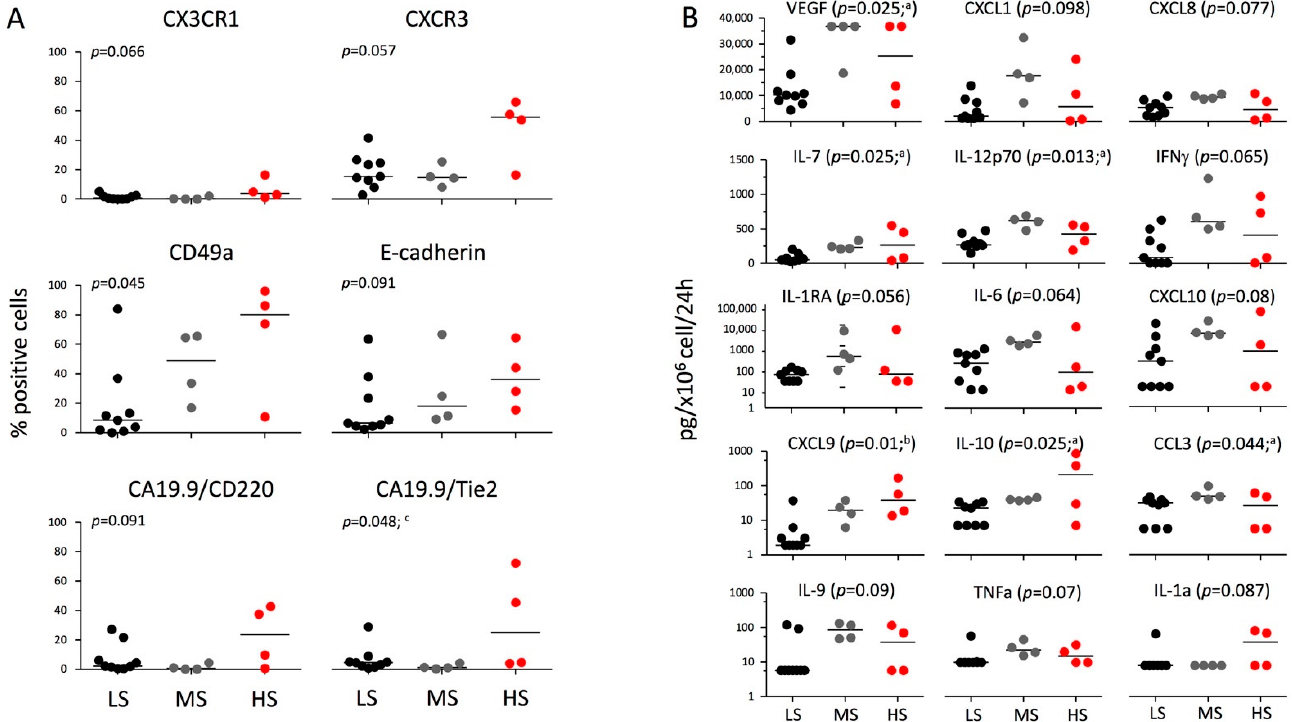
Figure 4. Expression of factors relevant for the biological behavior and secretome according to the different stemness degrees. ( A ) Percentage of expression of CX3CR1, CXCR3, CD49a, E-cadherin, CA19.9/CD220, and CA19.9/Tie2 in the 17 PDAC lines, divided according to the different stemness degrees: LS (CD44 + /CD24 + /ESA + < 5%, n = 9), MS (CD44 + /CD24 + /ESA + 6 – 20%, n = 4), and HS (CD44 + /CD24 + /ESA + > 20%, n = 4). ( B ) PDAC cell lines were cultured at a concentration of 1 × 10 6 cells/mL for 24 h and secreted factors were measured by a multiplex bead assay based on Luminex technology. Represented are the factors which resulted differentially expressed according to the different stemness degrees at p < 0.1 (see Table 1). The Kruskal–Wallis test with post hoc Dunn’s multiple comparison test was applied: a: p < 0.05 LS vs. MS; b: p < 0.05 LS vs. HS; c: p < 0.05 MS vs. HS. Black dot: Low-Stemness lines; Grey dot: Medium-Stemness lines; red dot: High-Stemness lines. The medians are represented as horizontal lines.